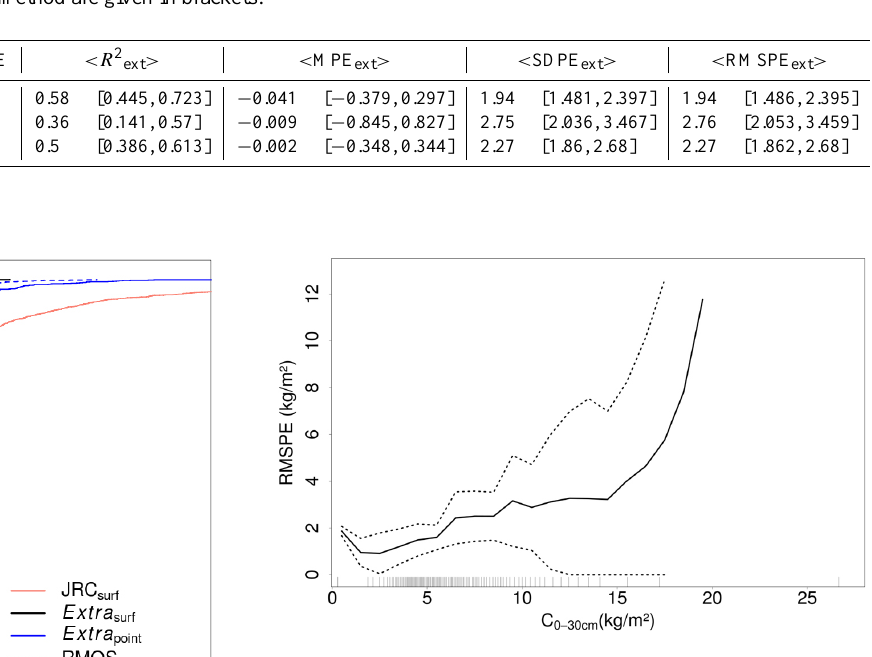
Fig. 4. Uncertainty of the Extra model, as a function of the organic carbon stock (30cm). Uncertainty values (i.e. < RMSPE ext > , re- sulting from cross-validations trials) are calculated as a function of predicted SOC stocks, grouped within intervals of 1kgm − 2 width, from 0 to 30kgm − 2 . The solid line represents the mean of uncer- tainty within each interval of SOC stocks values, and the upper and lower dashed lines represent the bounds of the CI 95% assuming a normal distribution within each interval. Tick marks at the lower border of the diagram give the 1% quantiles for the RMQS